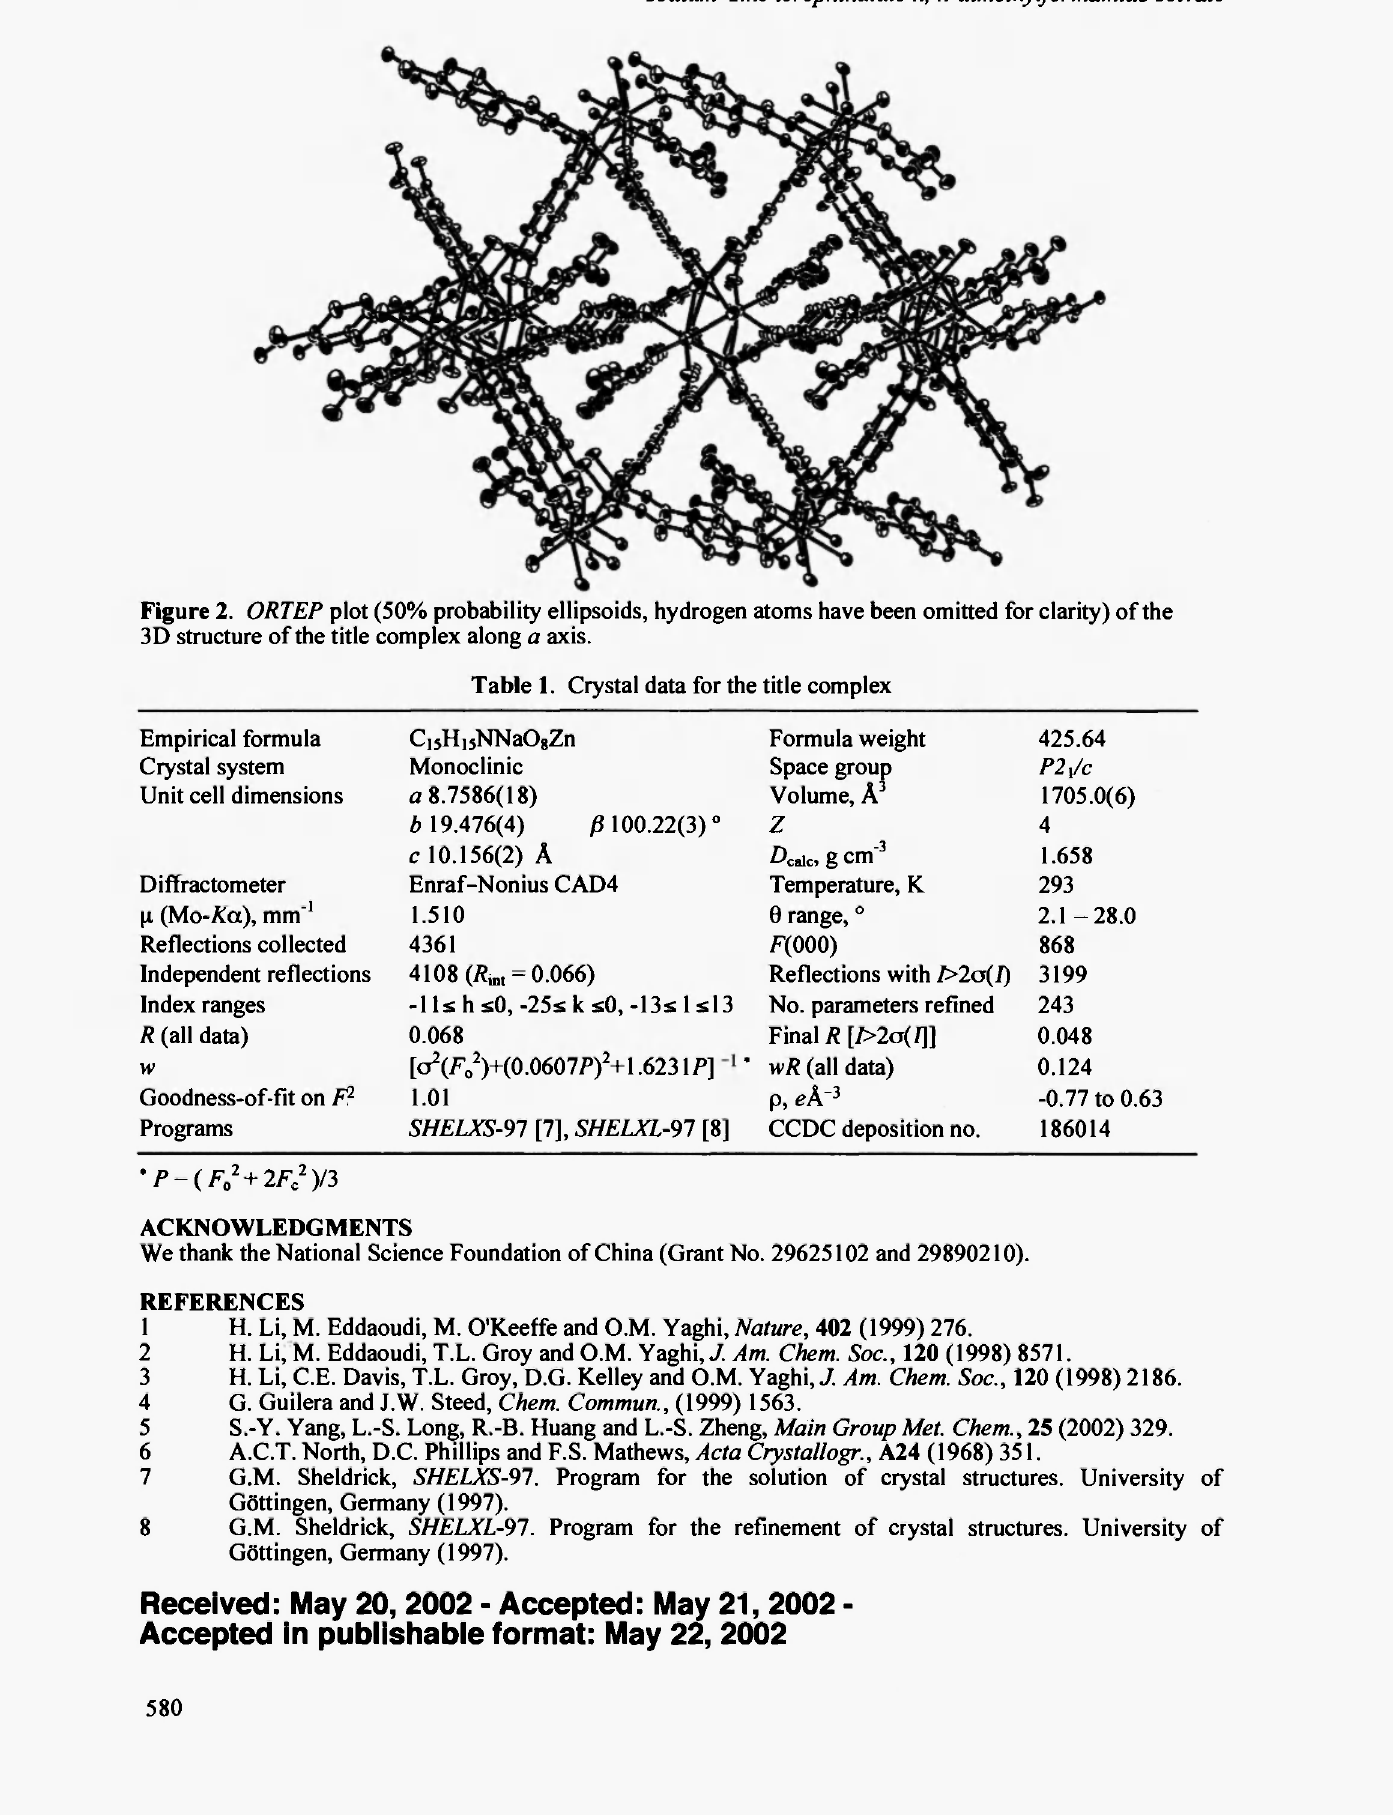
Figure 2. ORTEP plot (50% probability ellipsoids, hydrogen atoms have been omitted for clarity) of the 3D structure of the title complex along a axis. Table 1. Crystal data for the title